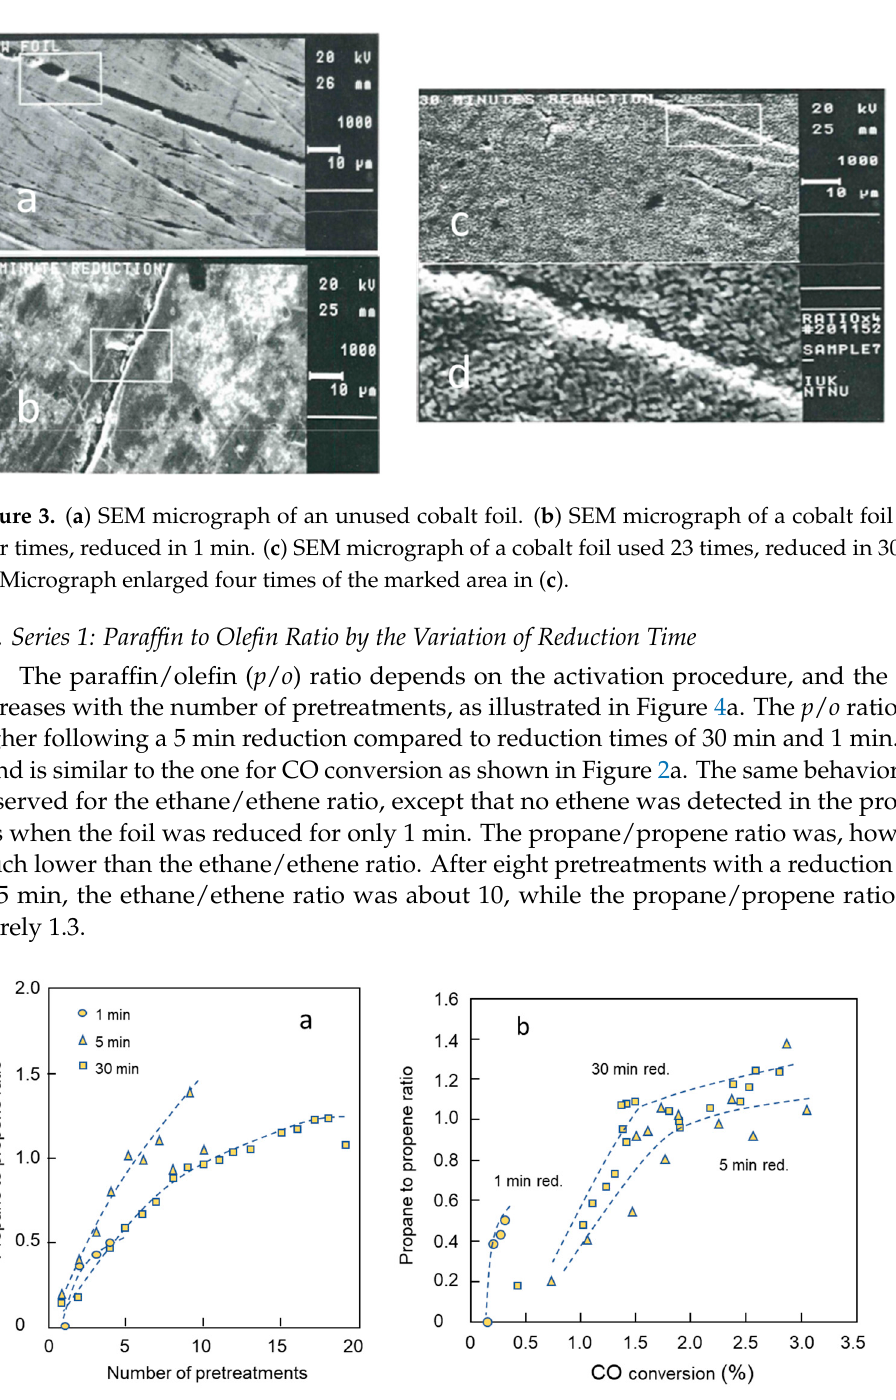
Figure 4. ( a ) The propane/propene ratio as a function of the number of pretreatments for different reduction times. ( b ) The propane/propene ratio as a function of CO conversion. Conditions: fresh foil for each reduction time of 1, 5, or 30 min; calcination and reduction at 300 °C; FTS at 220 °C and 1 bar; open symbols: flow, 3 Nml/min; closed symbols: 6 Nml/min; TOS for each FT synthesis: 70 min.